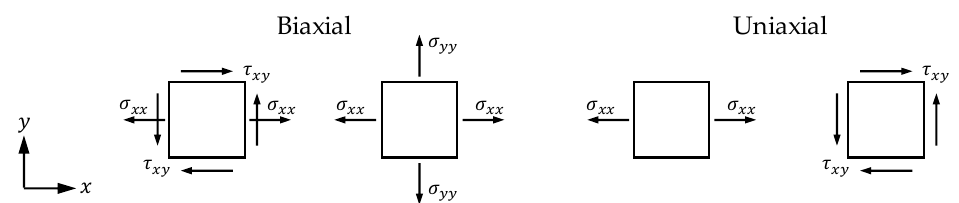
Figure 1. Common state of stress in fatigue testing: biaxial (e.g., normal and shear stresses or normal stresses in two directions); uniaxial (e.g., pure normal stress or pure shear stress).